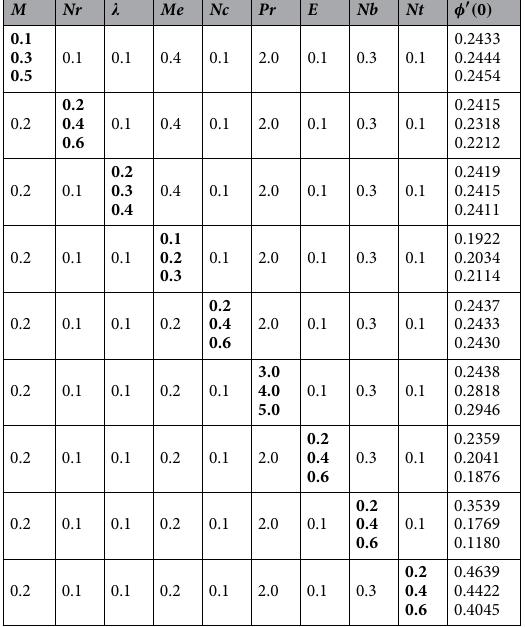
Table 4. Numerical computations of local Sherwood number φ ′ ( 0 ) for specific magnitudes of M , Nr , (cid:31) , Me , Nc , Pr , E , Nb and Nt .